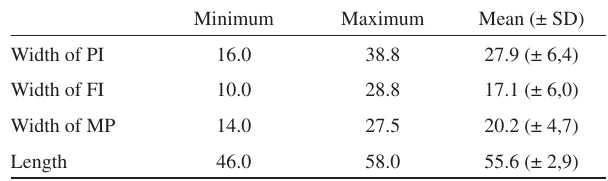
Table 1 - Dimensions of the MPFL